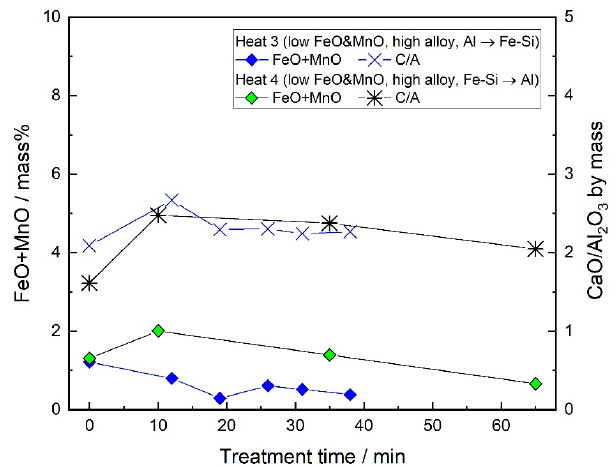
Figure 11. CaO/Al 2 O 3 ratio and FeO and MnO contents of the slag used for heat 3 and heat 4.